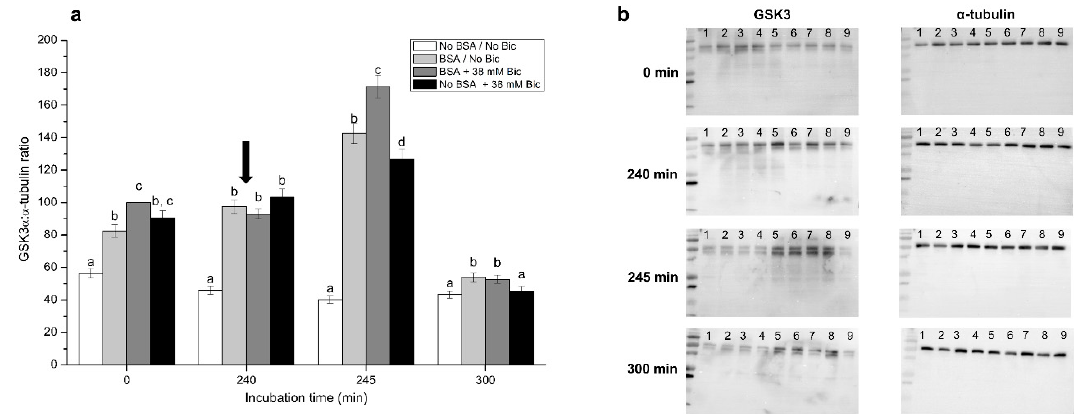
Figure 8. ( a ) Ratios between tyrosine-phosphorylated GSK3 α and α -tubulin following incubation with different concen- trations of bicarbonate (Bic; 0 mM, 38 mM) and BSA (0, 5 mg/mL) for 300 min. The black arrow indicates the time at which 10 μ g/mL of progesterone was added (i.e., 240 min) to induce acrosome exocytosis. Different superscripts (a–d) indicate significant differences ( p < 0.05) between treatments within the same time point. Data were corrected to a basal arbitrary value of 100 for the control point, which corresponded to the incubation in the medium containing BSA and 38 mM bicarbonate at 0 min. Results are shown as mean ± SEM for 12 independent experiments. ( b ) Representative blots for tyrosine-phosphorylated GSK3 and α -tubulin. Lane 1: No BSA/No Bic; Lane 2: BSA + 38 mM Bic; Lane 3: No BSA + 38 mM Bic; Lane 4: BSA/No Bic; Lane 5: No BSA + 5 mM Bic; Lane 6: BSA + 5 mM Bic; Lane 7: No BSA + 15 mM Bic; Lane 8: BSA + 15 mM Bic; Lane 9: No BSA/No Bic.